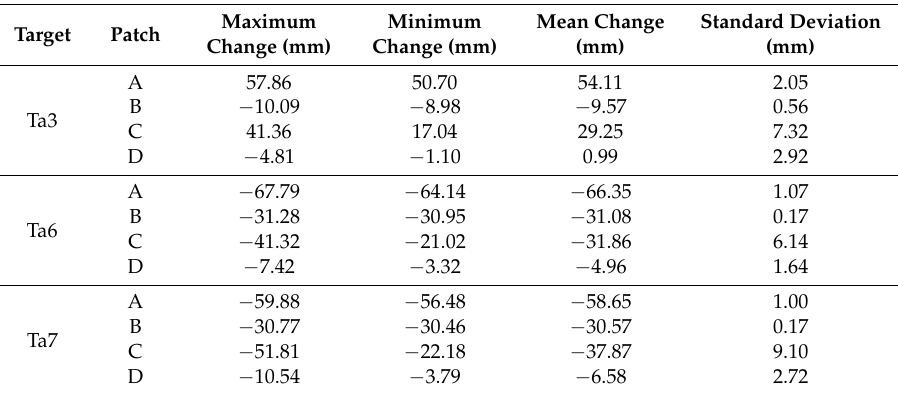
Table 1. Baseline change between patches and targets.